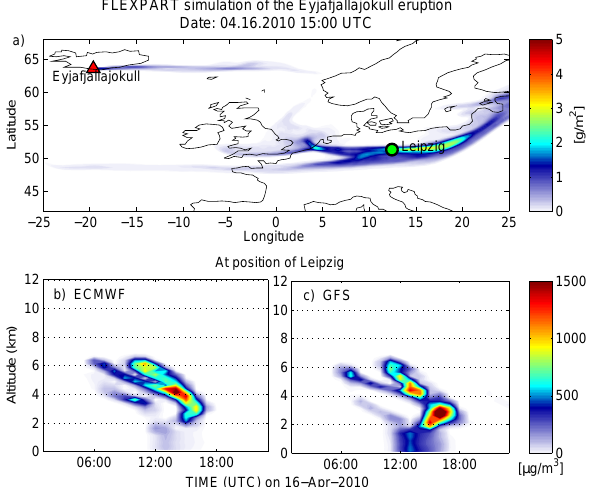
Fig. A5. Same as Fig. A1, but for 17 May at 02:00UTC.